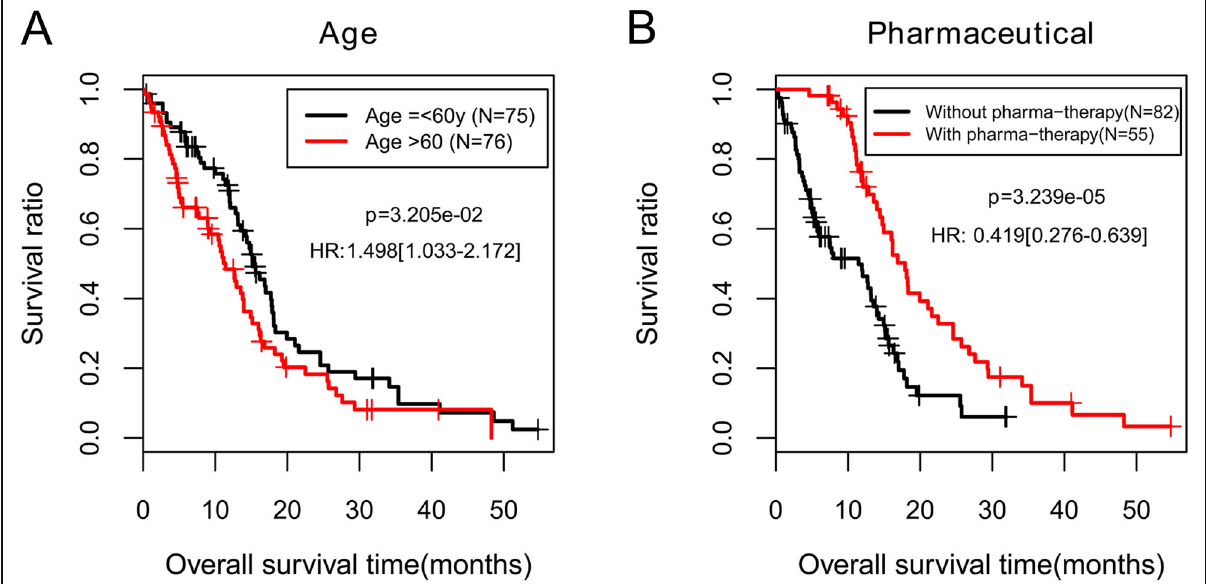
Fig. 4 Kaplan-Meier curves for overall survival of patients in the training set classified by clinical features. a , age; b , pharmaceutical therapy. All patients in the training set are divided by age or pharmaceutical therapy into two subgroups, respectively. The patients younger than or equal to 60 years have significantly longer overall survival time than the patients older than 60 years ( p = 3.205× 10 − 2 ). Markedly better survival is observed in the patients with pharmaceutical therapy compared to the patients without pharmaceutical therapy ( p = 3.239 × 10 − 5